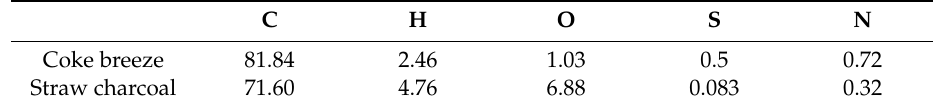
Table 1. Composition of solid fuel (dry basis, %).